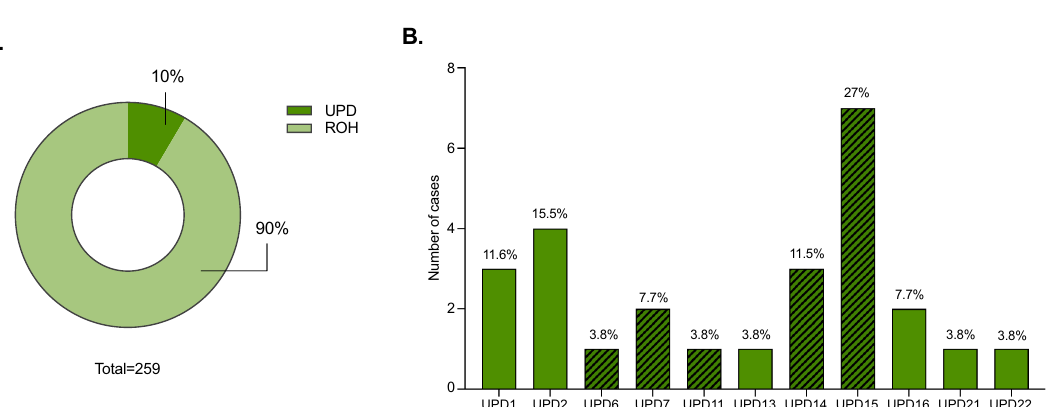
Figure 6. Frequency of copy neutral regions of homozygosity (ROH). ( A ) A total of 259 patients carried ROHs, 26 (10%) corresponding to uniparental disomy (UPD) cases. The remaining ROH in the other 233 patients (90%) were considered associated to different degrees of identity by descendent. ( B ) The histogram shows the frequency of UPDs per chromosome detected in our cohort. The crossed pattern represents pathogenic UPD known to encompass imprinting